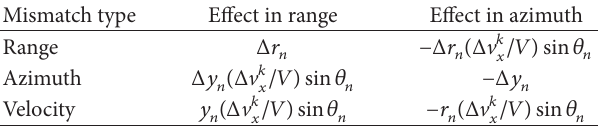
Table 2: Effect of mismatch on range and azimuth